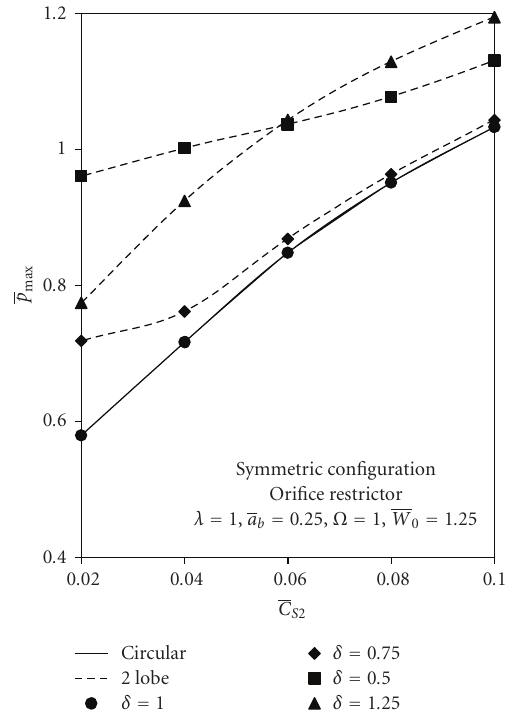
Figure 4: Variation of maximum pressure ( p ).